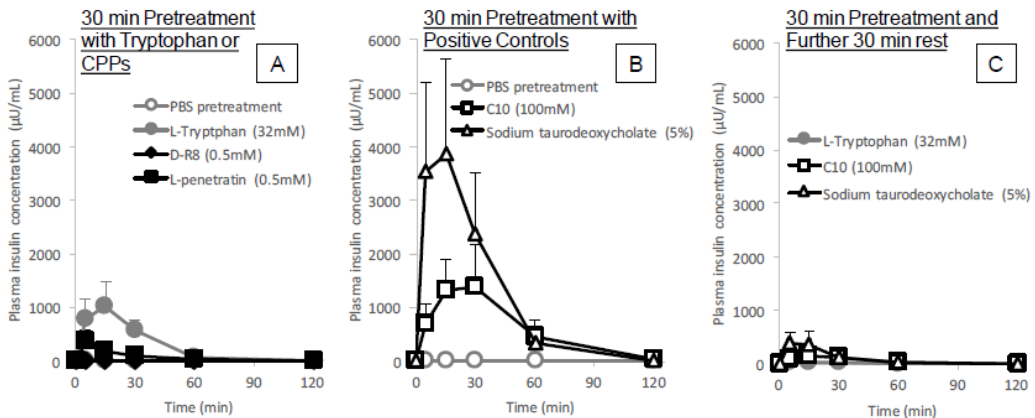
Figure 6. Time profiles of plasma insulin concentration after in situ administration of insulin (50 IU/kg) into rat ileal loop pretreated with L -tryptophan (32 mM), D -R8 (0.5 mM), L -penetratin (0.5 mM), C10 (100 mM), or sodium taurodeoxycholate (5%). In the results shown in Panels ( A , B ), insulin solution was administered immediately after washing the pretreatment solution from the ileal loop. For the results shown in Panel ( C ), insulin solution was administered at 30 min after washing out the pretreatment solution. Each data point represents the mean ± SEM of N = 3–4.